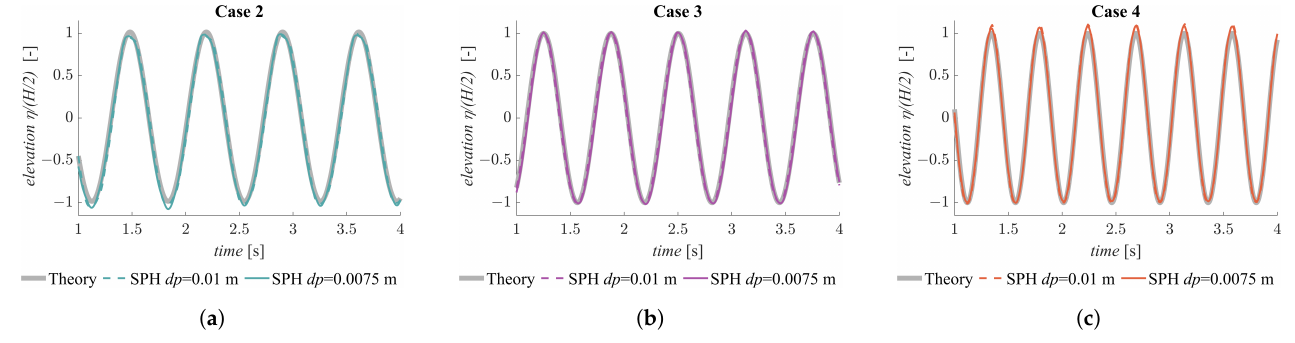
Figure 5. Free-surface elevation for three wave conditions in presence of steady current.